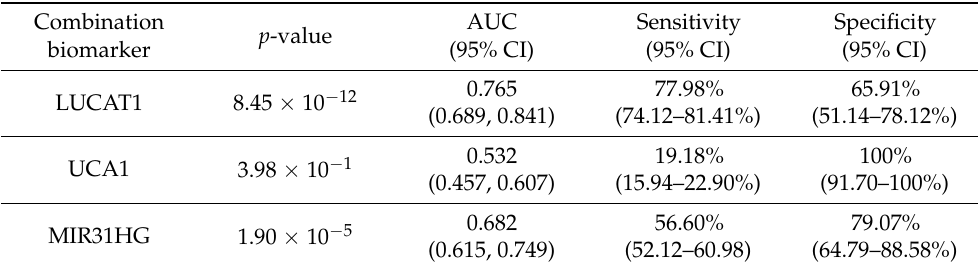
Table 3. ROC analysis of LUCAT1, MIR31HG, and